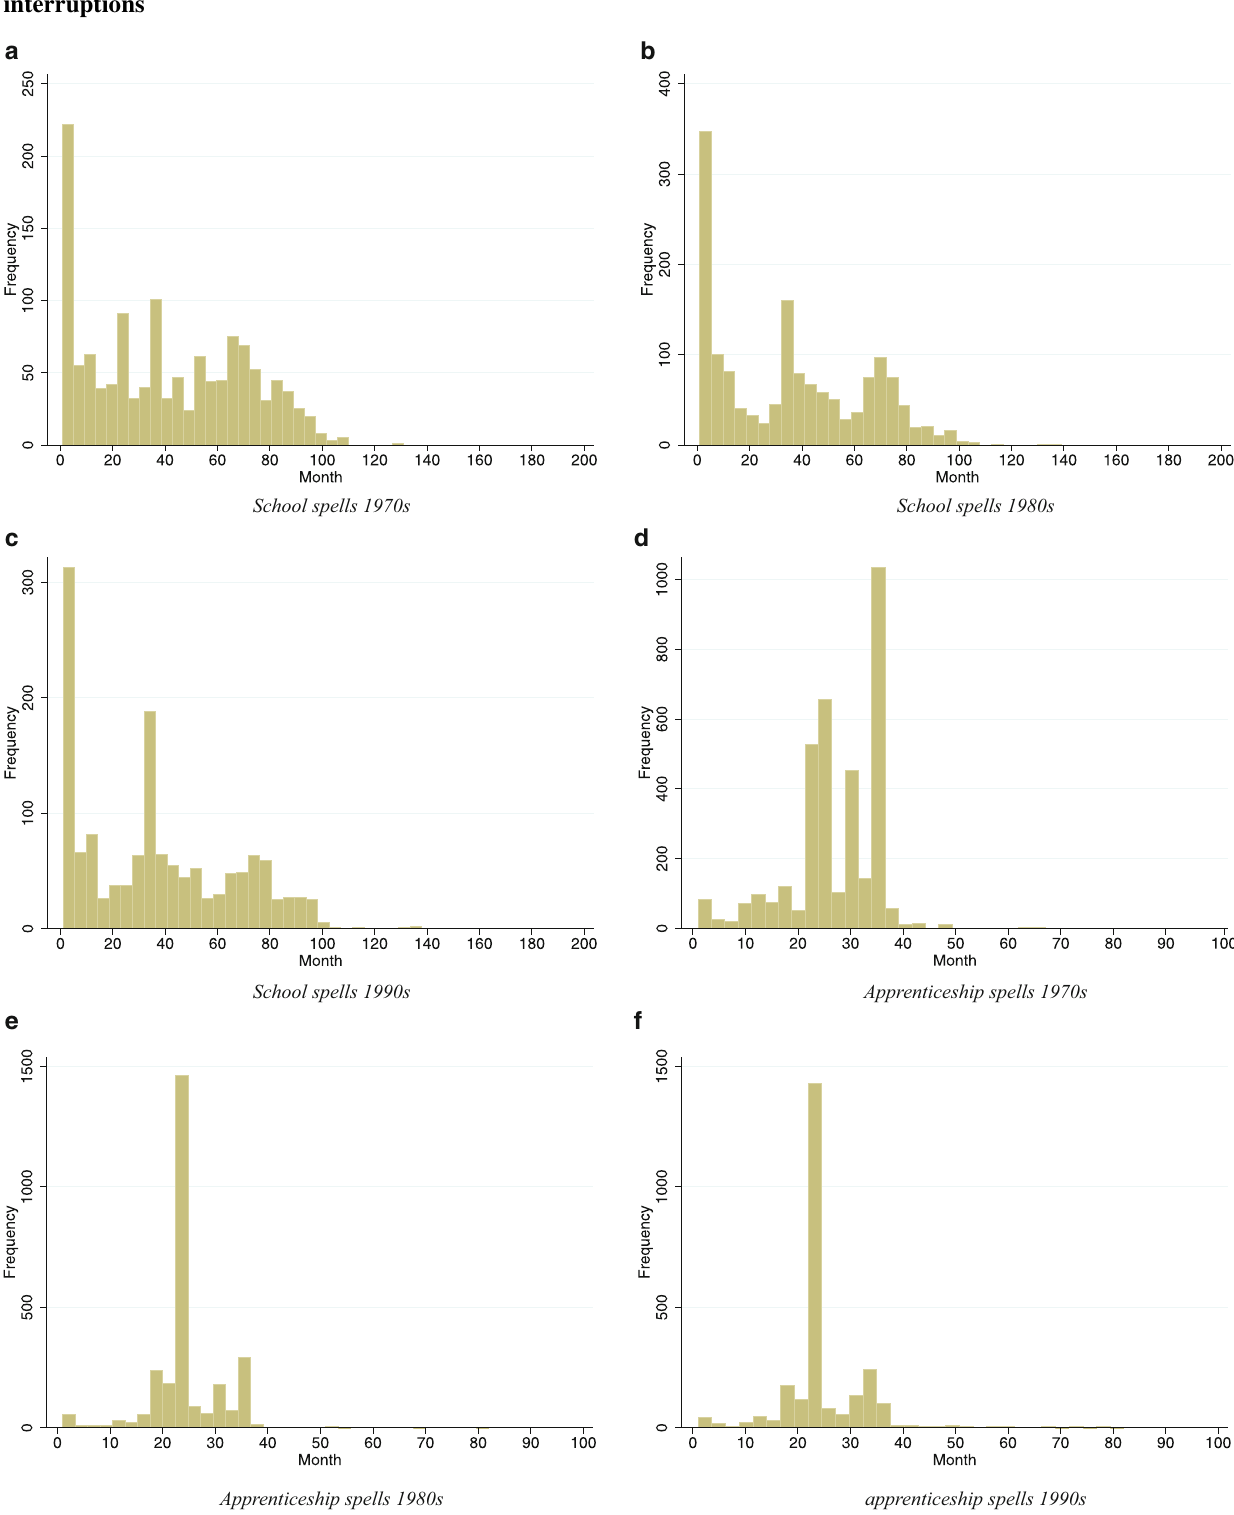
Fig. 4 Distribution of school and apprenticeship spells by period. ( Source: BASiD 2007. Notes: The figure shows the distribution of the length of school ( a–c ) and apprenticeship spells ( e–f ). School spells coded as SES =1. Apprenticeship spells are coded as SES =2. We close interruptions of type 1 and type 3 if the length of the interruption is less than 12 months and if the interruptions do not occur due to regular employment